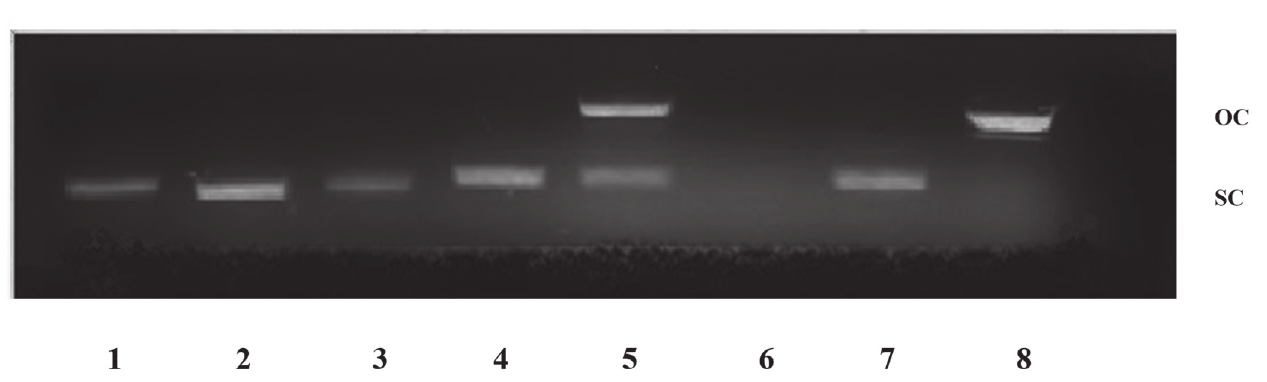
FIGURE 3 – Gel electrophoresis of pUC-19 DNA in the presence of Cu(II) and AA. Saturated air solution ([O = 5.5; T = (21 ± 2) ºC. All lanes (1) contain only pUC-19 DNA = 5.0 ng μL -1